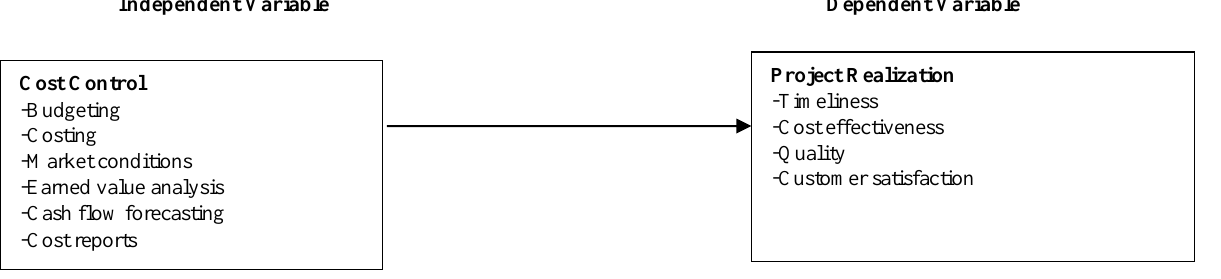
Figure 1 : Conceptual